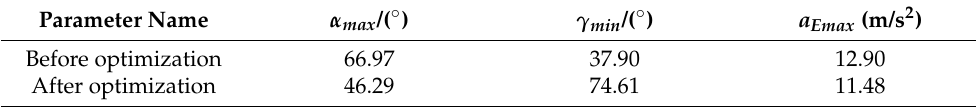
Table 2. Comparison of motion characteristics parameters.